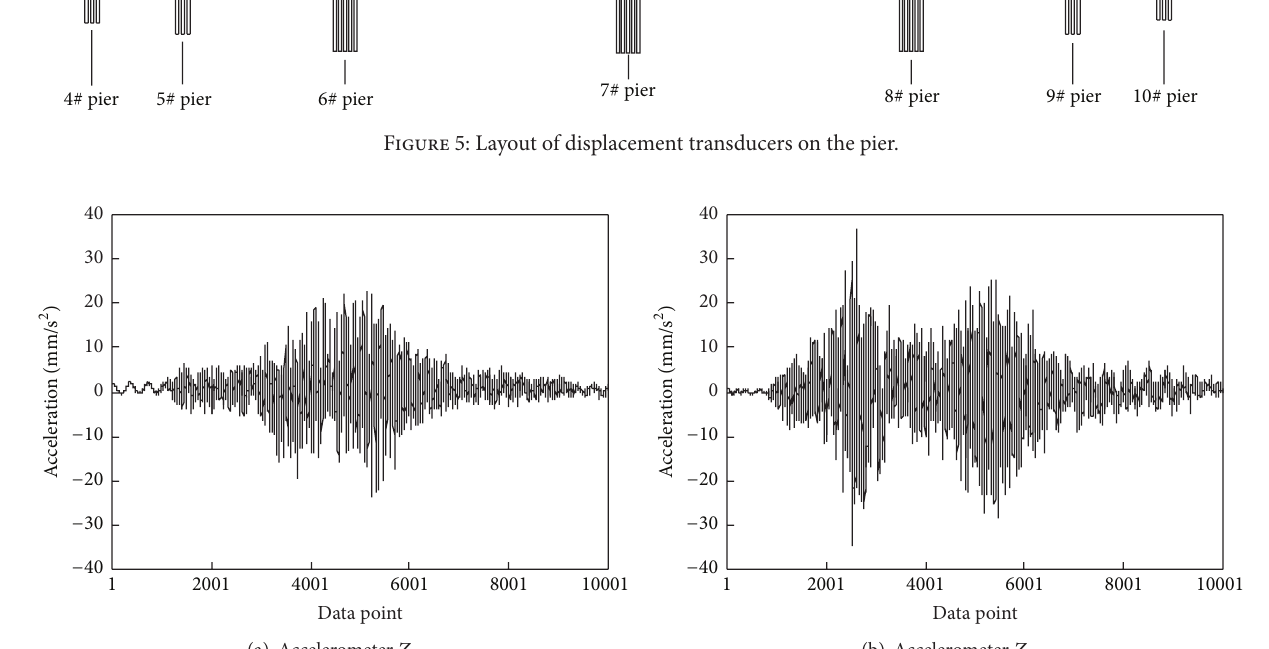
Figure 6: Transverse acceleration time histories of the main girder induced by a high-speed